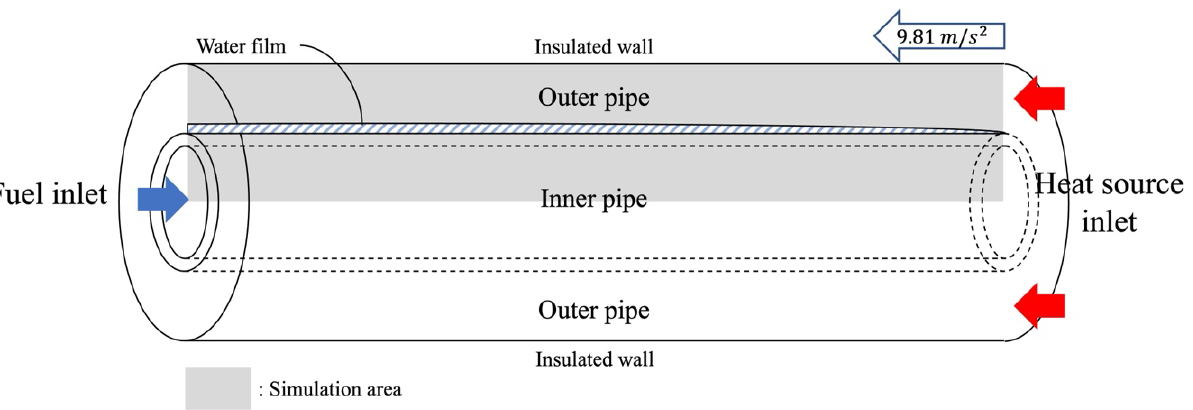
Figure 1. Schematic diagram of the annular methanol–steam reformer (MSR).